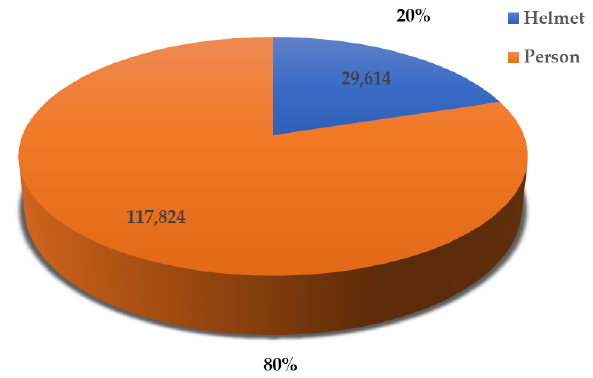
Figure 9. Percentage of ground truth for each object.